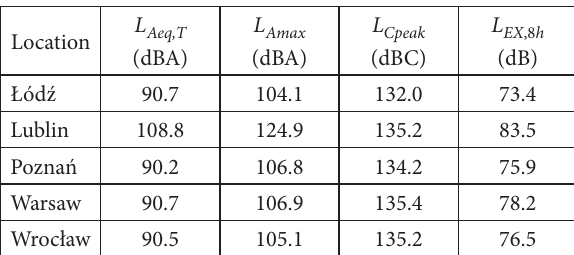
Table 2. The highest recorded values of the measured parameters